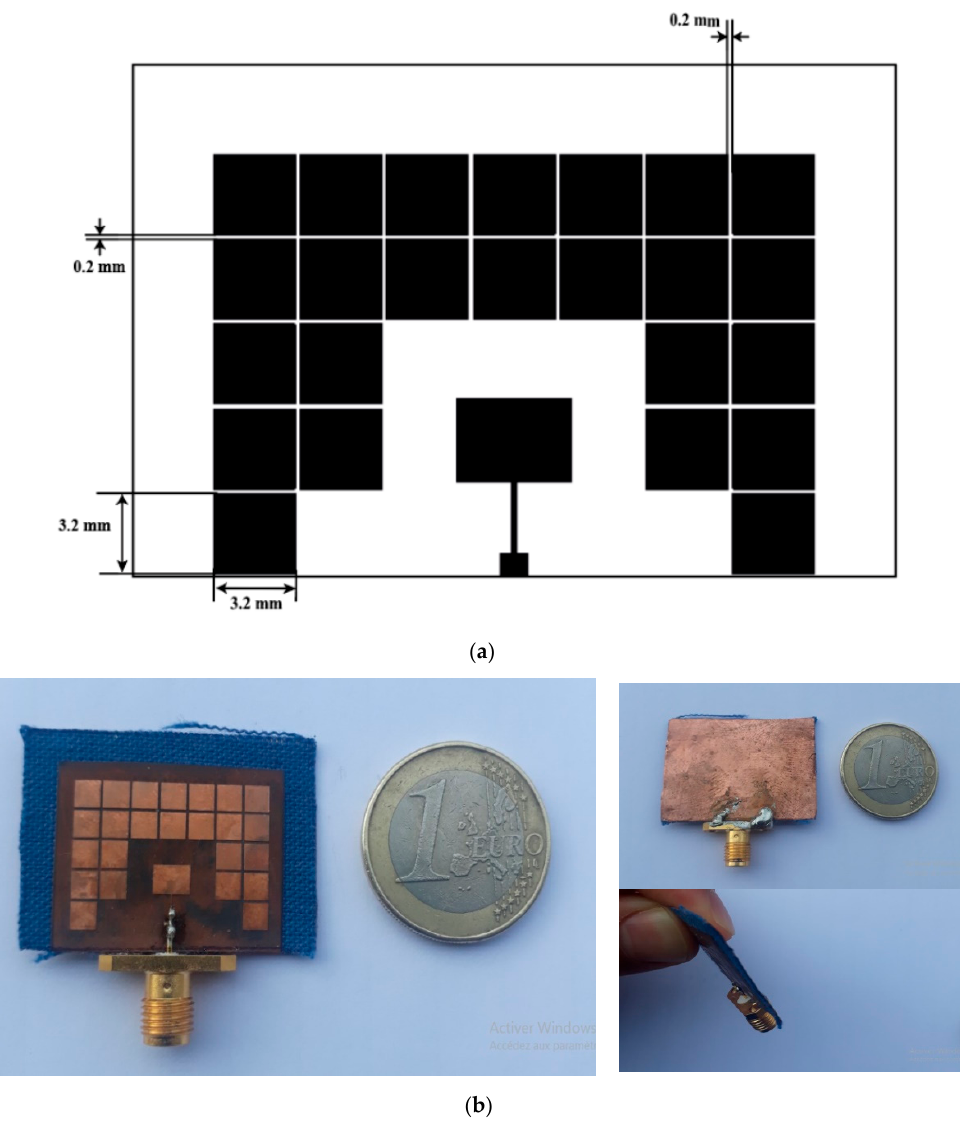
Figure 8. Geometry of the proposed antenna: ( a ) top view of the patch with EBG; ( b ) fabricated antenna.